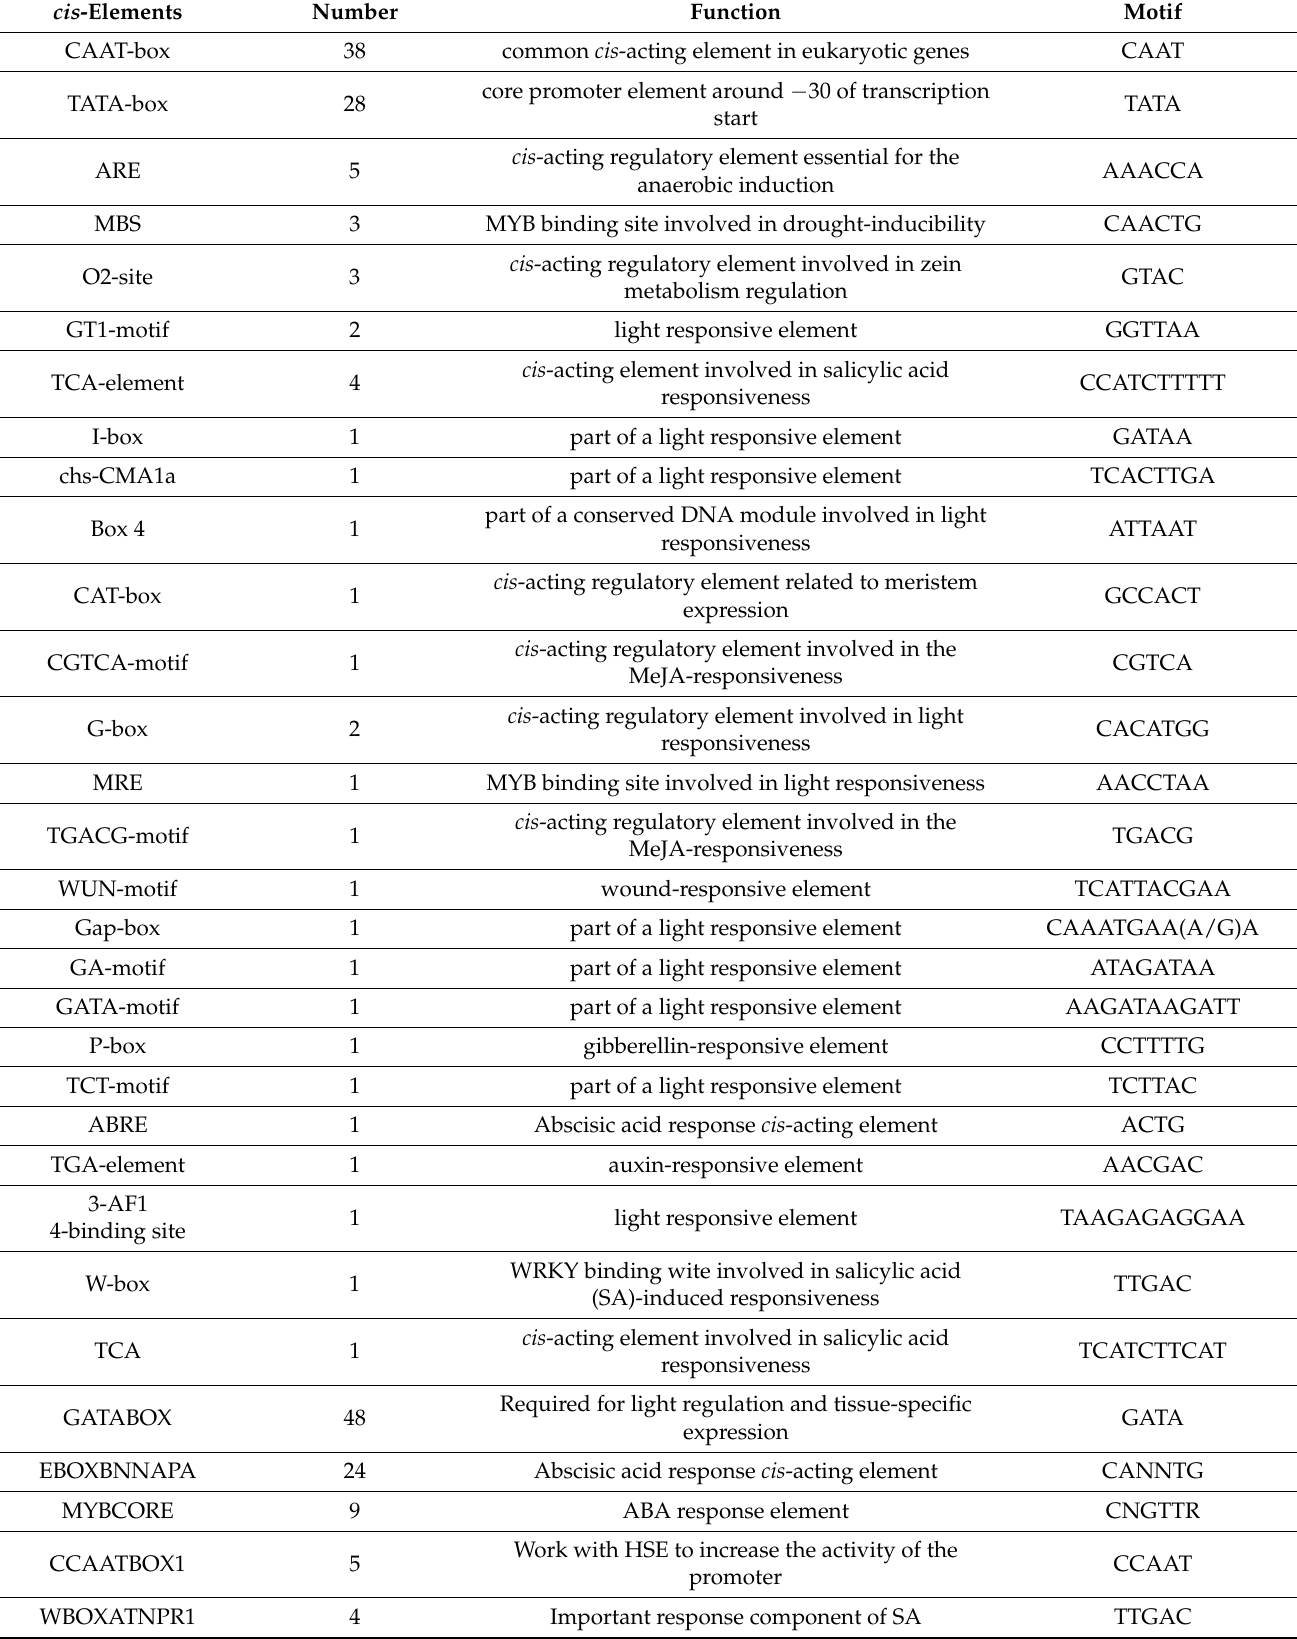
Table 1. Biological analysis of the cis -acting element of the TkSRPP3 promoter from T. kok-saghyz